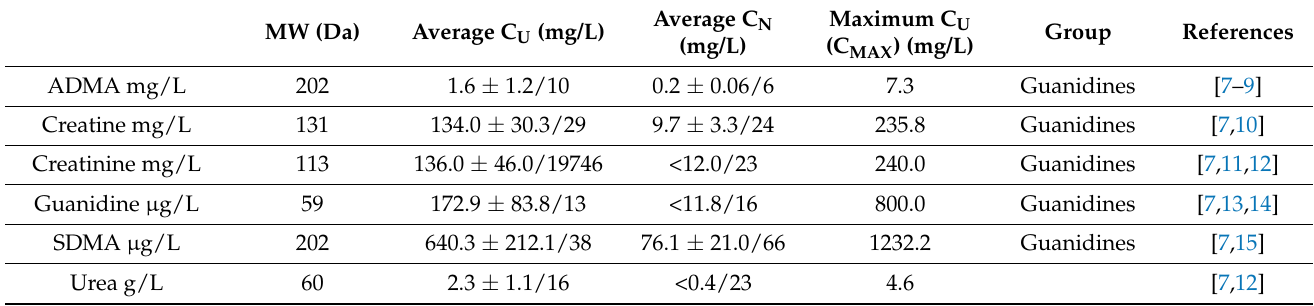
Table 1. Retention solutes first group: low molecular weight (<500 D) and non-known protein binding.